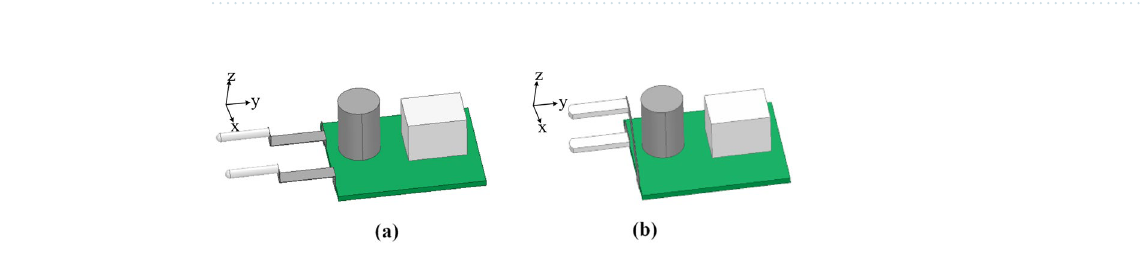
Figure 25. 3D schematic diagram: ( a ) original structure; ( b ) proposed structure.